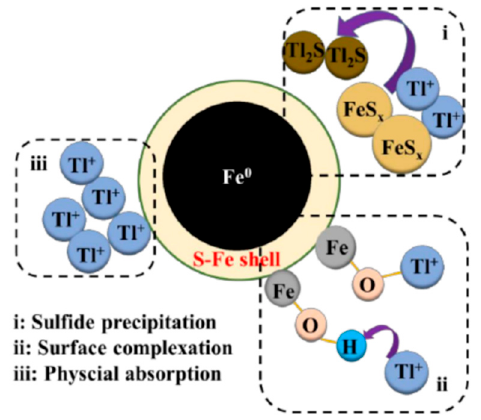
Figure 4. Schematic diagram of thallium adsorption mechanism of S-ZVI material